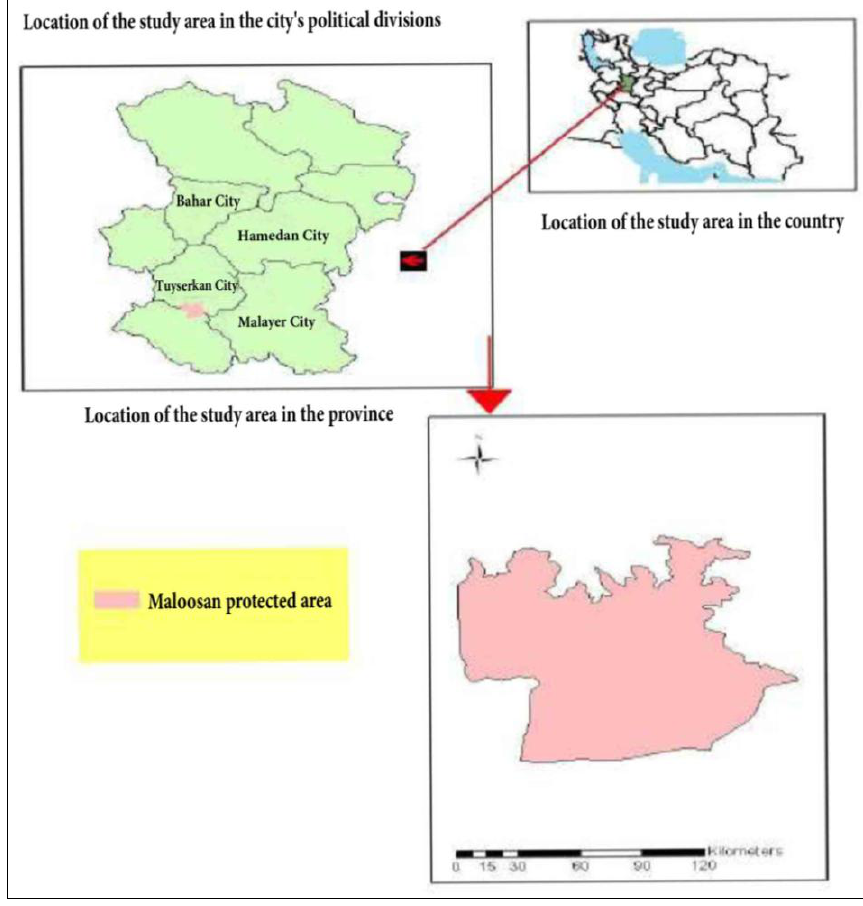
Fig. 1. The position of the Maloosan protected area in Hamadan province (Iranian Environmental Protection Agency, 2013c)